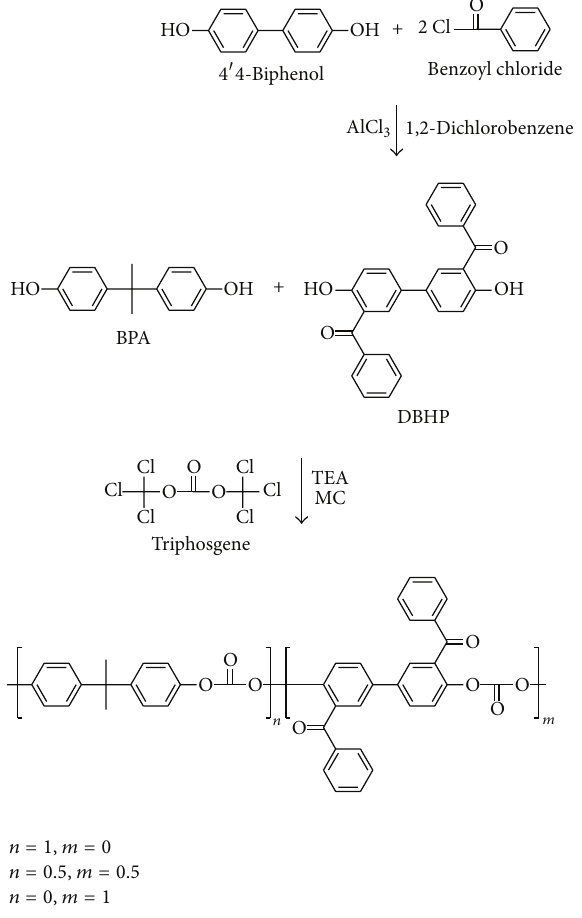
Scheme 1: Synthesis of DBHP monomer and DBHP-PCs.